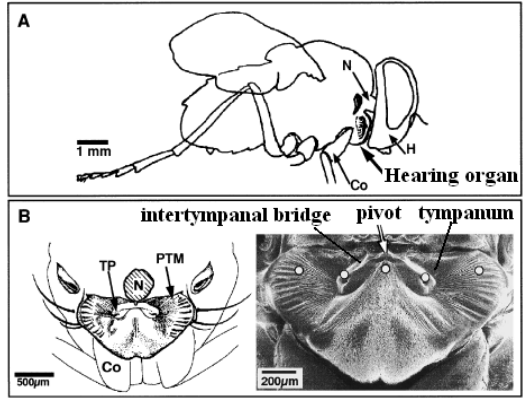
Figure 2. Hearing organ of parasitoid fly ormia ochracea and its mechanical